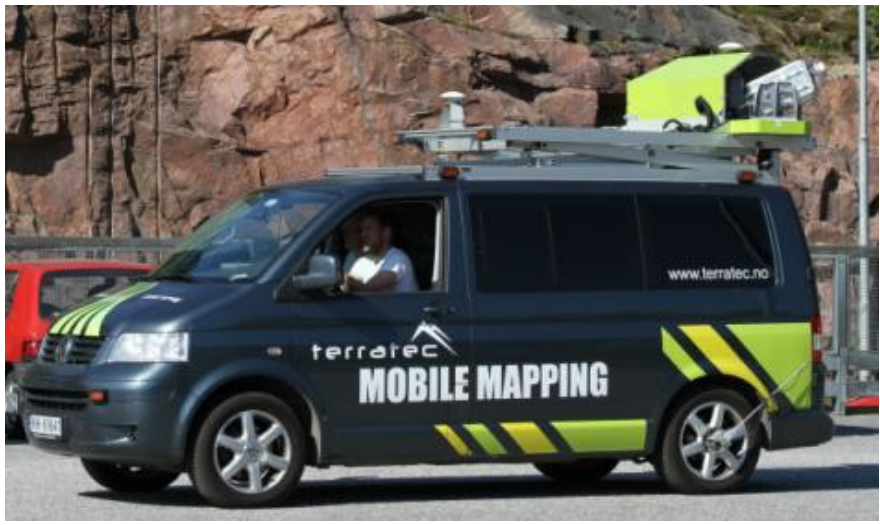
Figure 14. TerraTec AS mapping the Espoonlahti test field with an Optech Lynx Mobile